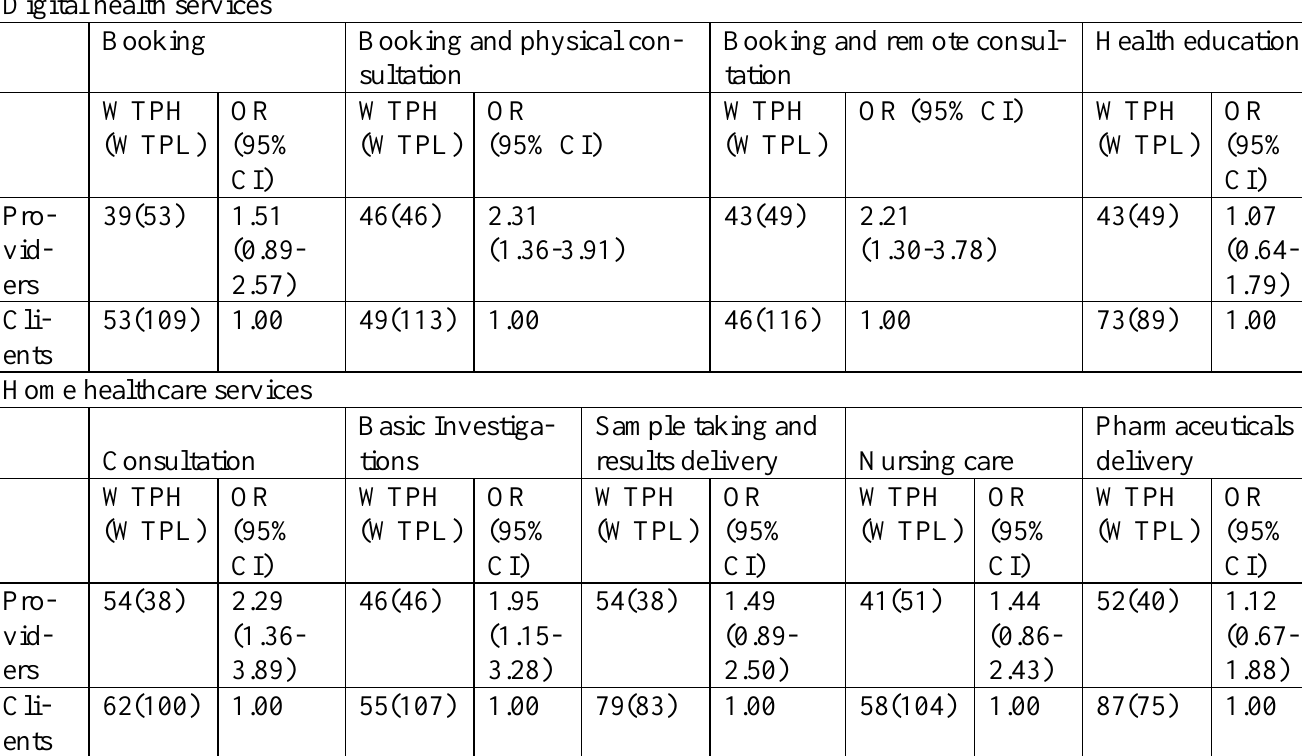
Table 4: Respondents willingness to pay higher than medium (WTPH) and willingness to pay the medium and lower (WTPL) between healthcare providers and clients Digital health